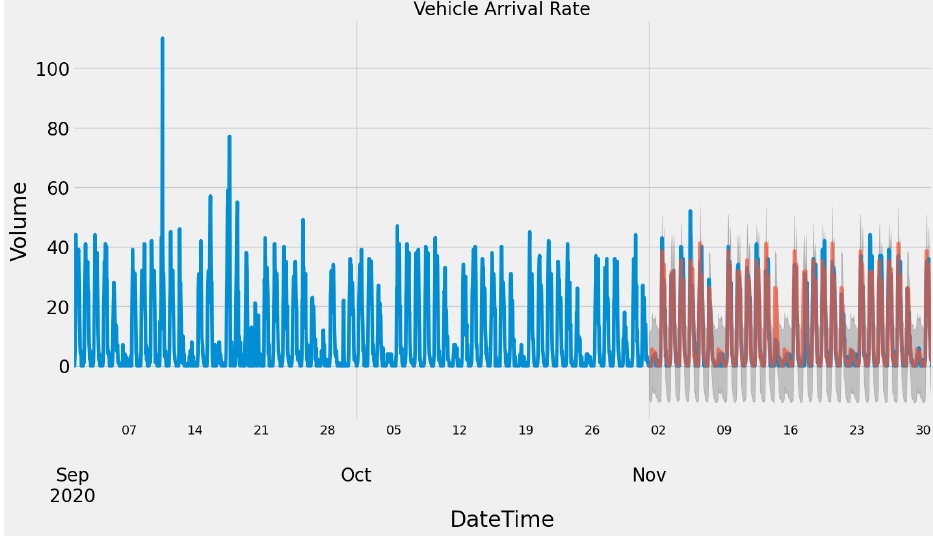
Figure 5. Sample of SARIMAX forecasting in arrivals for November 2020 at Location